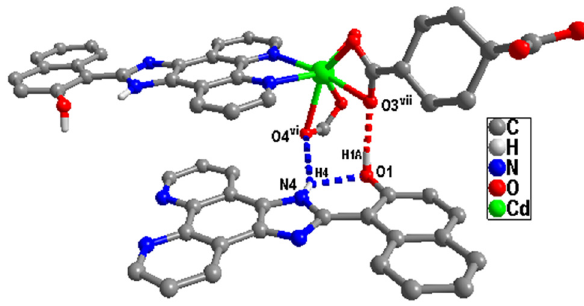
Figure 6: View of the O – H ⋯ N and N – H ⋯ O hydrogen bonds inter -